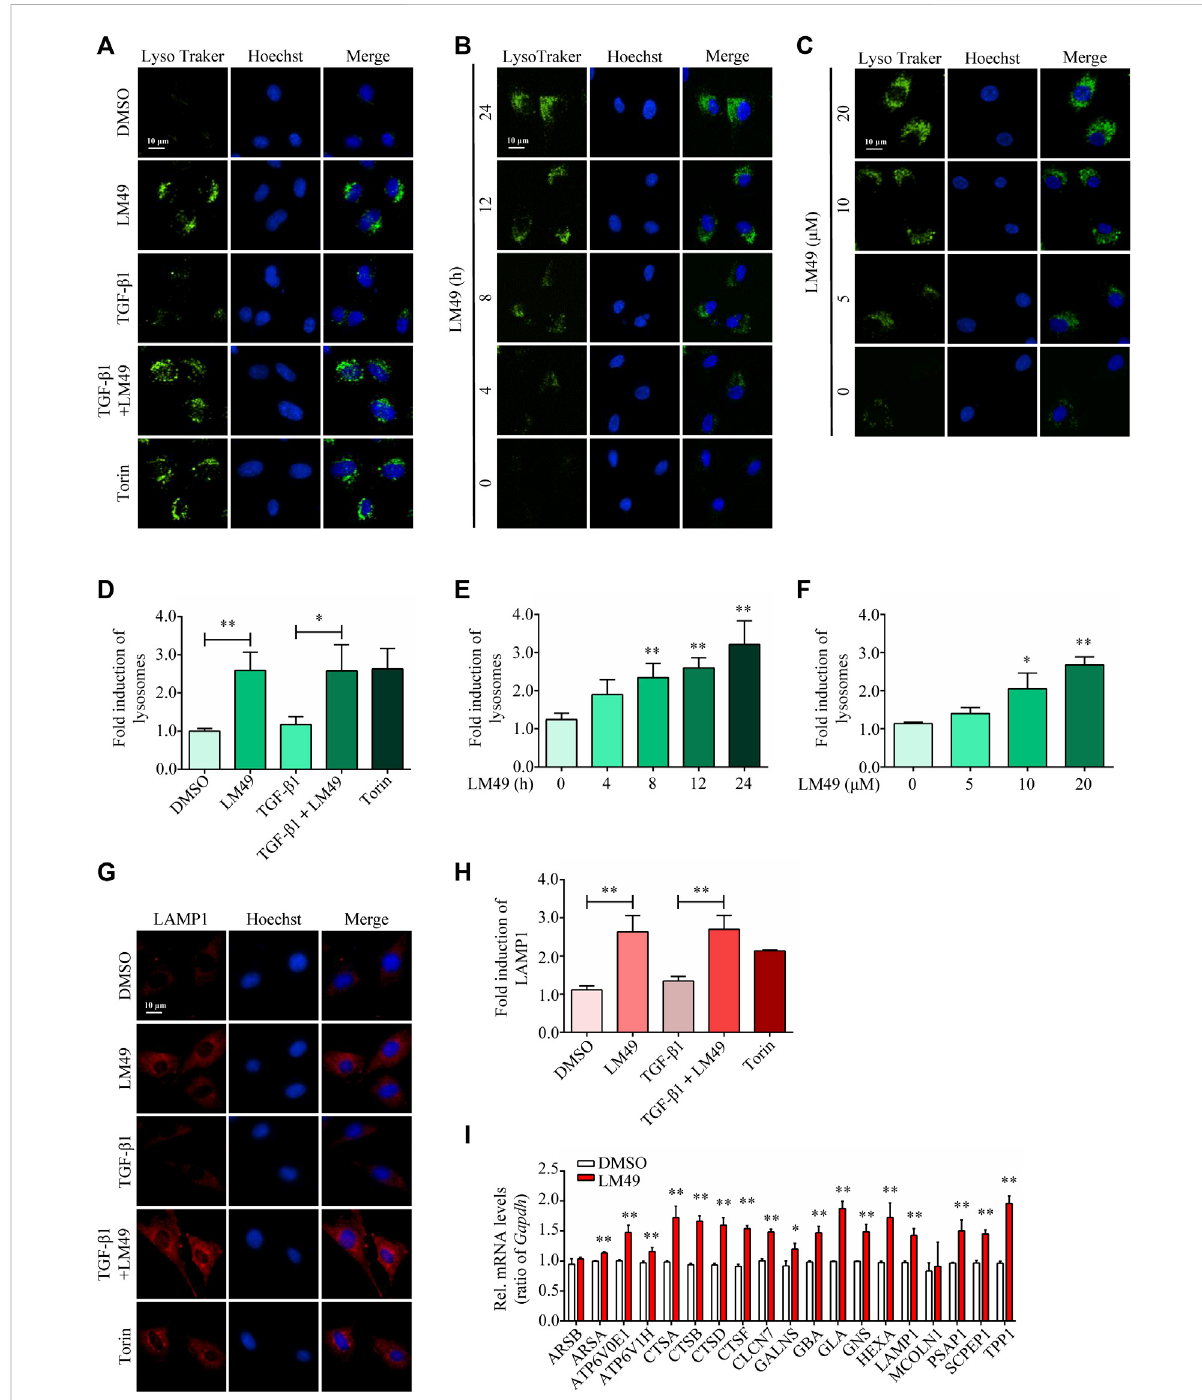
FIGURE 3 LM49 increases thelysosome biogenesis andupregulates lysosome-related genes. (A) LysoTrackerGreenstaining inNRK49Fcells treatedwith LM49 (20 μ M) in the absence or presence of TGF- β 1 (5 ng/ml) for 24 h or Torin1 (1 μ M) for 3 h (Scale bar, 10 μ m). (B) LysoTracker Green staining in NRK49FcellstreatedwithLM49(20 μ M)fortheindicatedtimepoints.(Scalebar,10 μ m). (C) LysoTrackerGreenstaininginNRK49Fcellstreatedwith indicated doses of LM49 for 24 h (Scale bar, 10 μ m). (D) Quanti fi cation of LysoTracker Green intensity of (A) . * p < 0.05, ** p < 0.01 compared with DMSO group orTGF- β 1 alonetreated group (n = 3). (E,F) Quanti fi cation ofLysoTracker Green intensityof (B,C) . * p < 0.05, ** p < 0.01 compared withDMSOgroup(n=3). (G) ImmunostainingofendogenousLAMP1inNRK49FcellstreatedwithLM49 (20 μ M)intheabsence orpresenceofTGF- β 1(5 ng/ml)for24 horTorin1(1 μ M)for3 h(Scalebar,10 μ m). (H) Quanti fi cationofLAMP1intensityof (G) .** p < 0.01comparedwithDMSOgroupor TGF- β 1 alone treated group (n = 3). (I) Quantitative RT-PCR analysis of the mRNA levels of lysosome-related genes in NRK49F cells treated with DMSO or LM49 (20 μ M) for 24 h * p < 0.05, ** p < 0.01 compared with DMSO group (n =